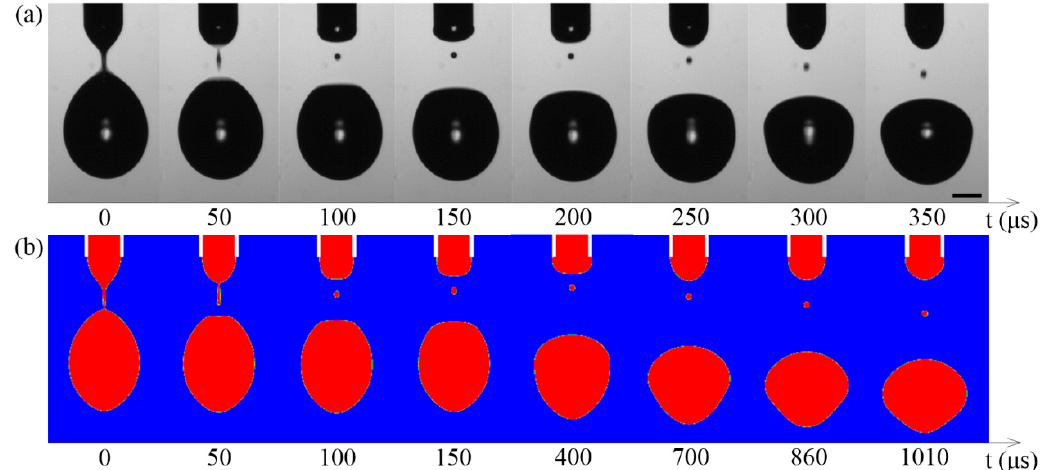
Figure 2. The comparison of ( a ) the experiment and ( b ) the simulation. The conductivity of the liquid is 2.3 μ S/cm. The viscosity of the liquid is 3.5 mPa ∙ s. The supplied flow rate is 223.5 μ L/min. Scale bar = 100 μ m.